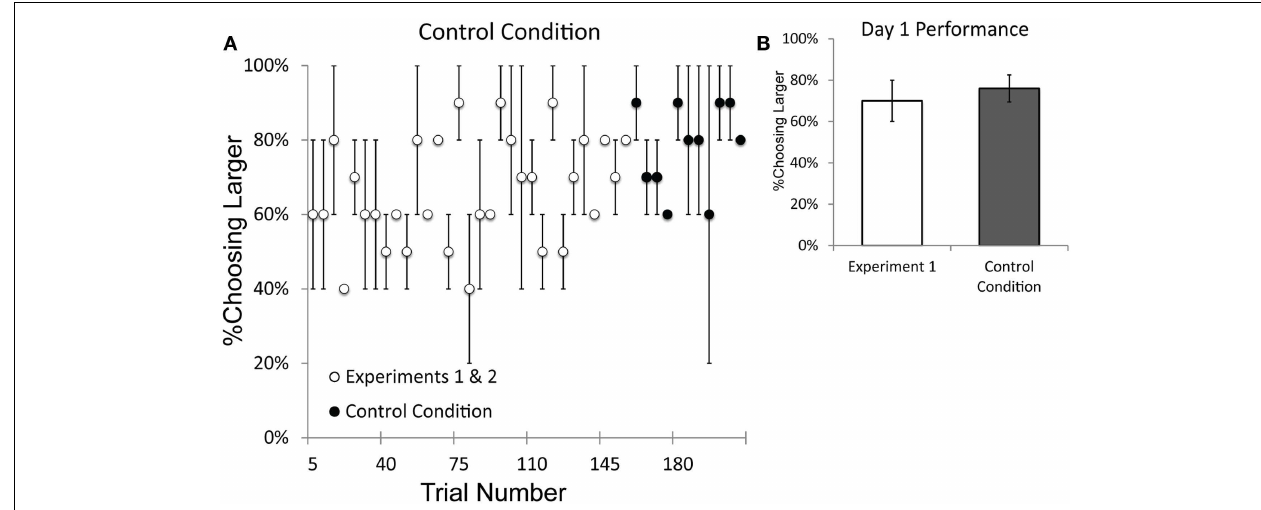
of performance on the first day of testing for Experiment 1 vs. the first day of testing on the Control Condition.The data presented from Experiment 1 only include numerical pairs that are as easy as those from the Control Condition (numerical ratios ≤ 0.5). Error bars represent standard error of the mean difference between